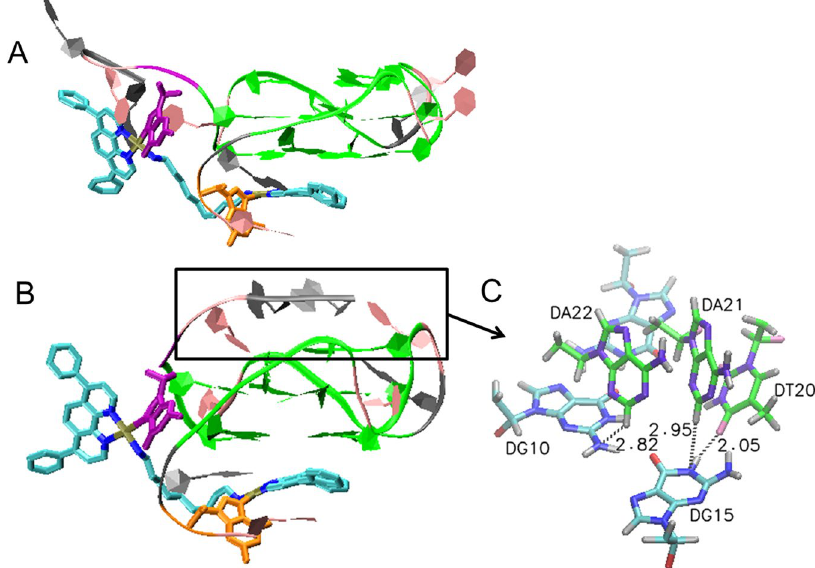
Figure 4. Two docking structures of dual cross-linked Pt3 -GQ complex ( A : conf1; B : conf2). Pt3 and G 2 / G 19 were shown in Licorice model (Pt: brown; N: blue; C : cyan; Cl: red; G 2 : orange; G 19 : purple), and the rest G-quadruplex was shown in ribbon model (T: pink; A: gray; G: green; G 2 : orange; G 19 : purple). ( C) The hydrogen bond formed between 3 ′ -A 22 A 21 T 20 trinucleotides and top G-tetrad (G triad in cyan(C)/blue(N)/ red(O); 3 ′ -trinucelotides in